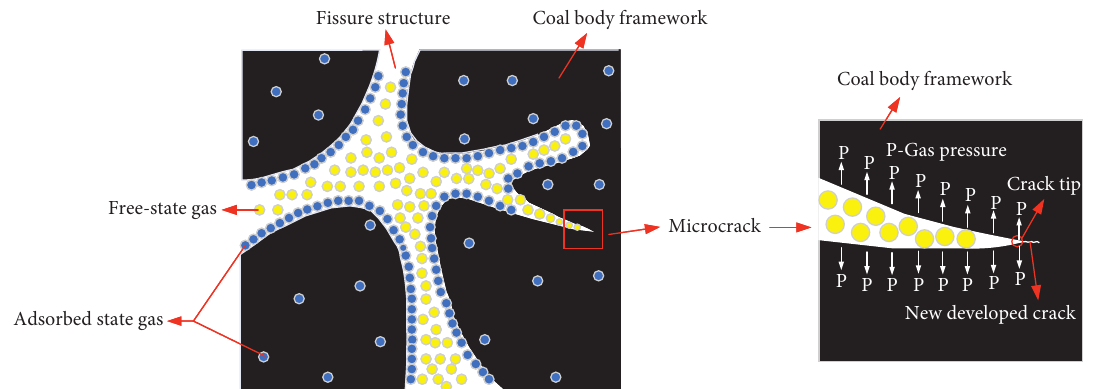
Figure 18: Wedge-opening effect of free gas on coal pore and fissure.